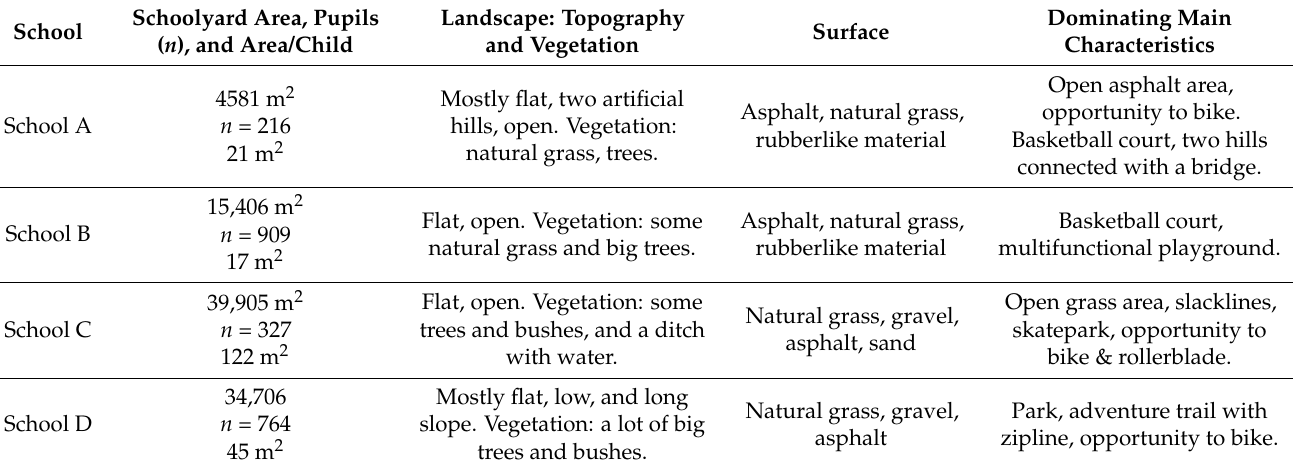
Table 1. Schoolyard characteristics in four schools in